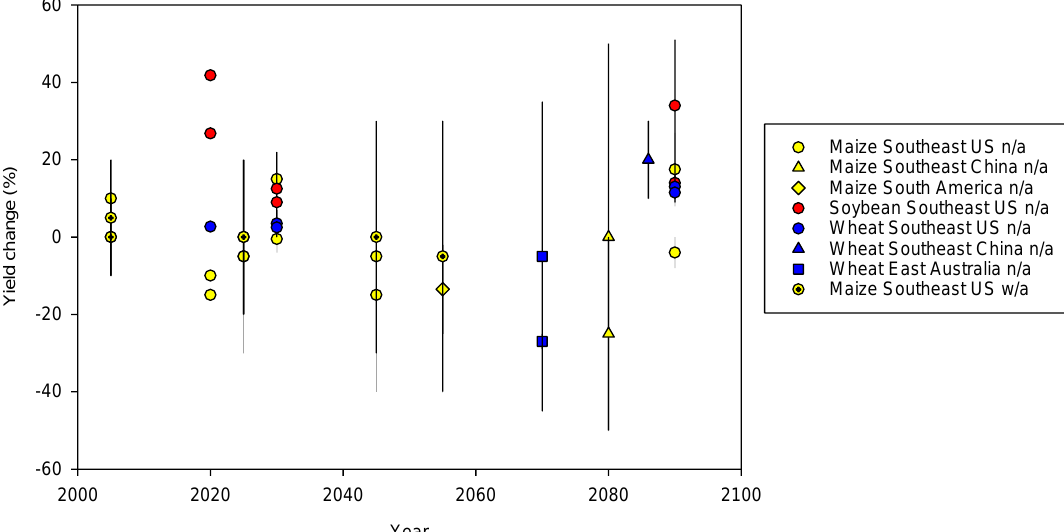
Figure 7. Impact of climate change with adaptation (w/a) and without adaptation (n/a), if available, for wheat, soybean, and maize yields for humid subtropical regions in the southeast U.S., southeast China, South America, and east Australia (See Table 3 for details). Note: bars refer to reported ranges of yield changes, whereas single points refer to mean yield change.